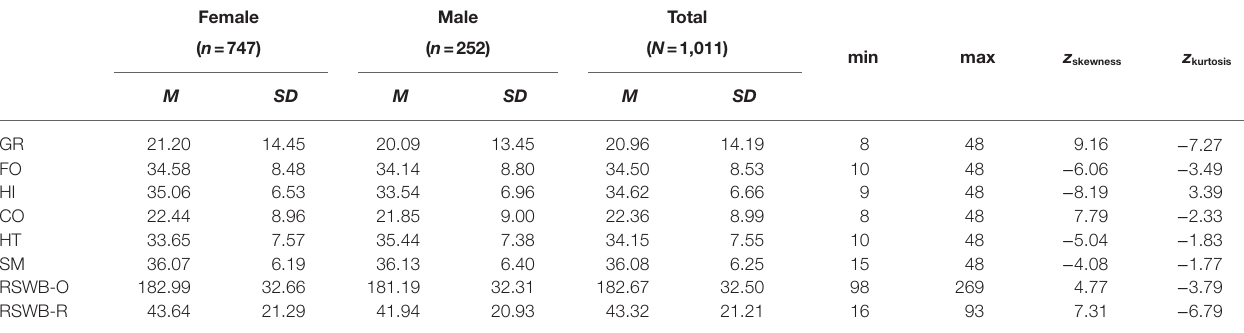
TABLE 3 | Descriptive statistics of the Swedish version of the MI-RSWB